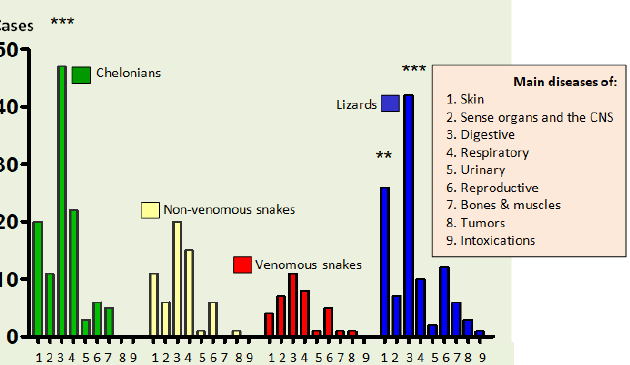
Figure 2. Comparative disease distribution/no. of cases/reptile species/disease types; comparison of chelonians vs. venomous and non-venomous snakes (where *** means p < 0.001) and lizards vs. venomous and non-venomous snakes ( where** means p < 0.01, and *** means p < 0.001).